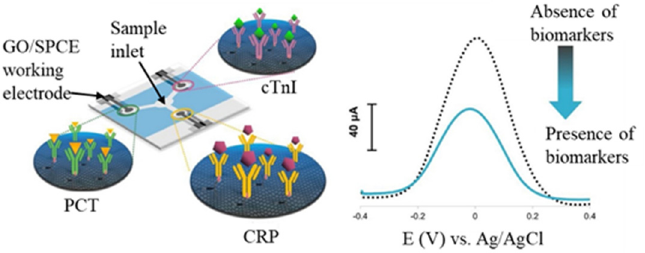
Figure 10. Scheme of multiplexed electrochemical paper-based analytical devices (ePADs) with three individual immunosensors. The label-free DPV peak current decreases after immunoreaction. Redrawn from [118]. ©Elsevier Publishing.